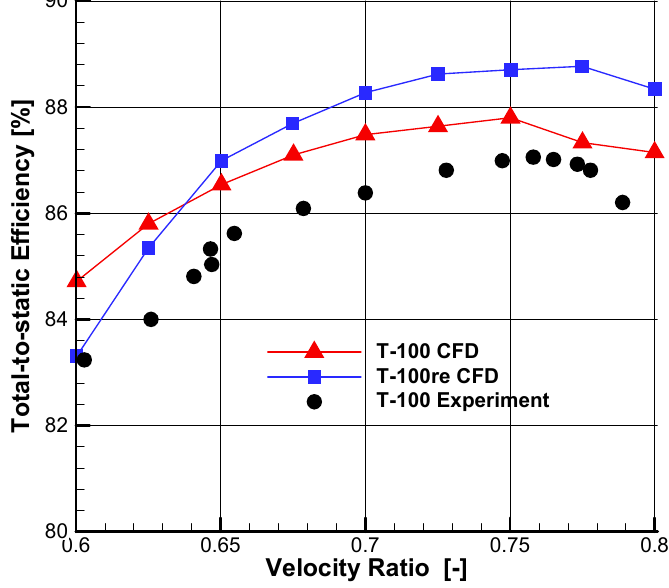
Figure 11. Comparison of total-to-static efficiency.